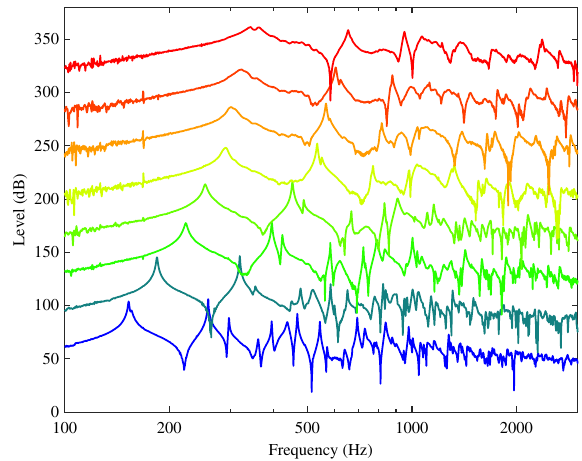
Figure 8. Results for variations of head tension: waterfall plot of the frequency response deduced from microphone recordings of head taps with eight different settings of the head tension in a banjo. Tensions are indicated by colour: blue for the lowest tension, going through the rainbow sequence to red for the highest tension. Curves are spaced by successive intervals of 40 dB for